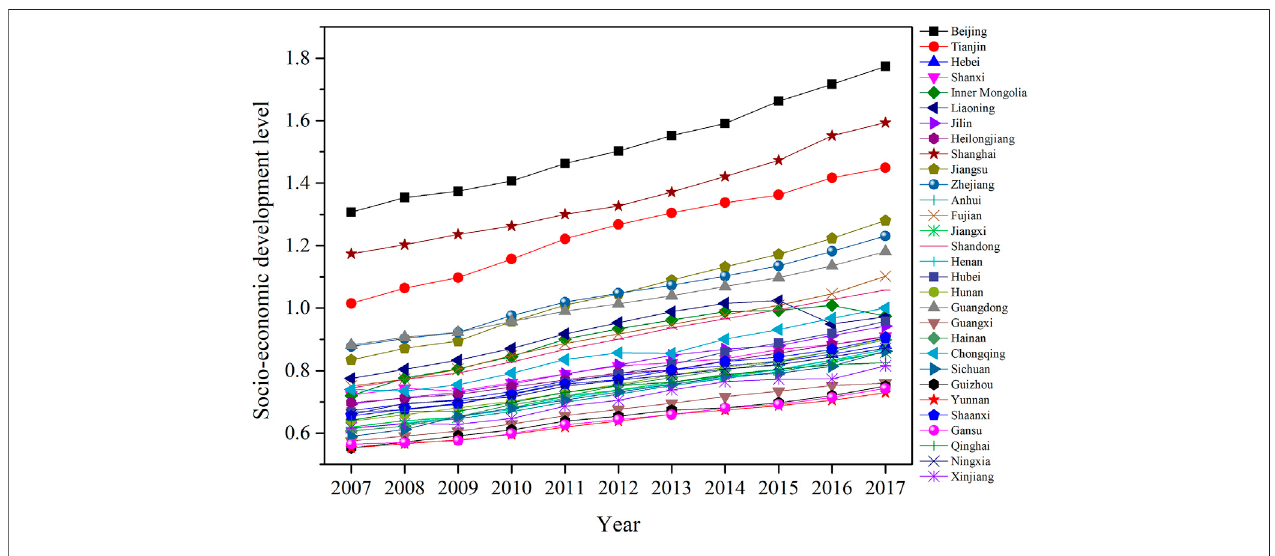
FIGURE 3 | Progress of SED in the 30 regions in China from 2007 to 2017.